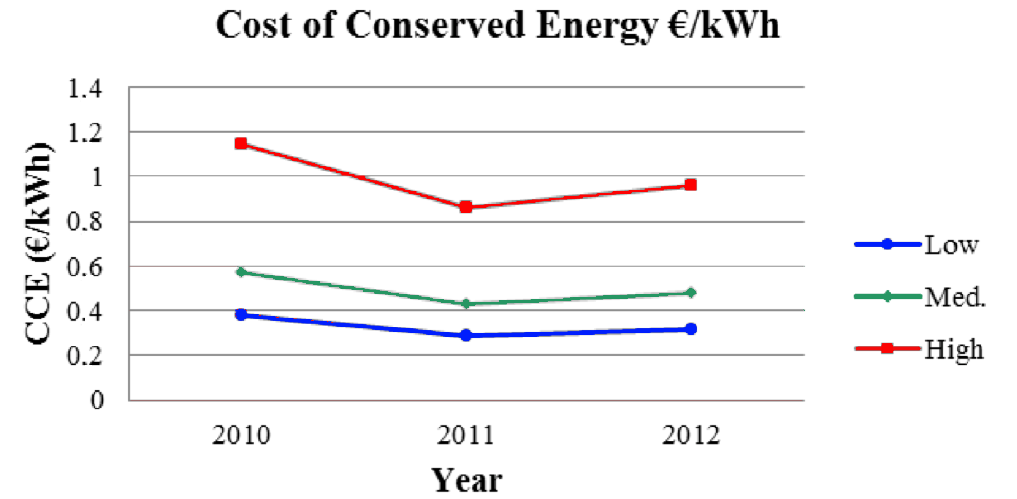
Figure 9. Annual trends of cost of conserved energy for three efficiency base case scenarios—constant discount